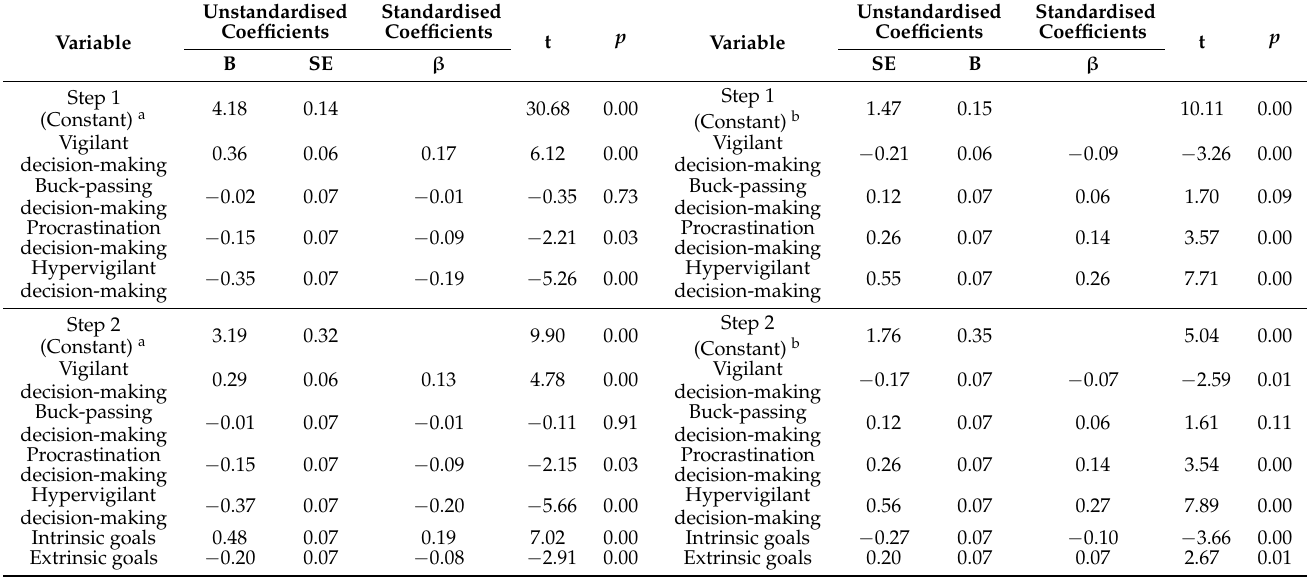
Table 5. Hierarchical regression analyses for Relatedness Satisfaction a and Frustration b